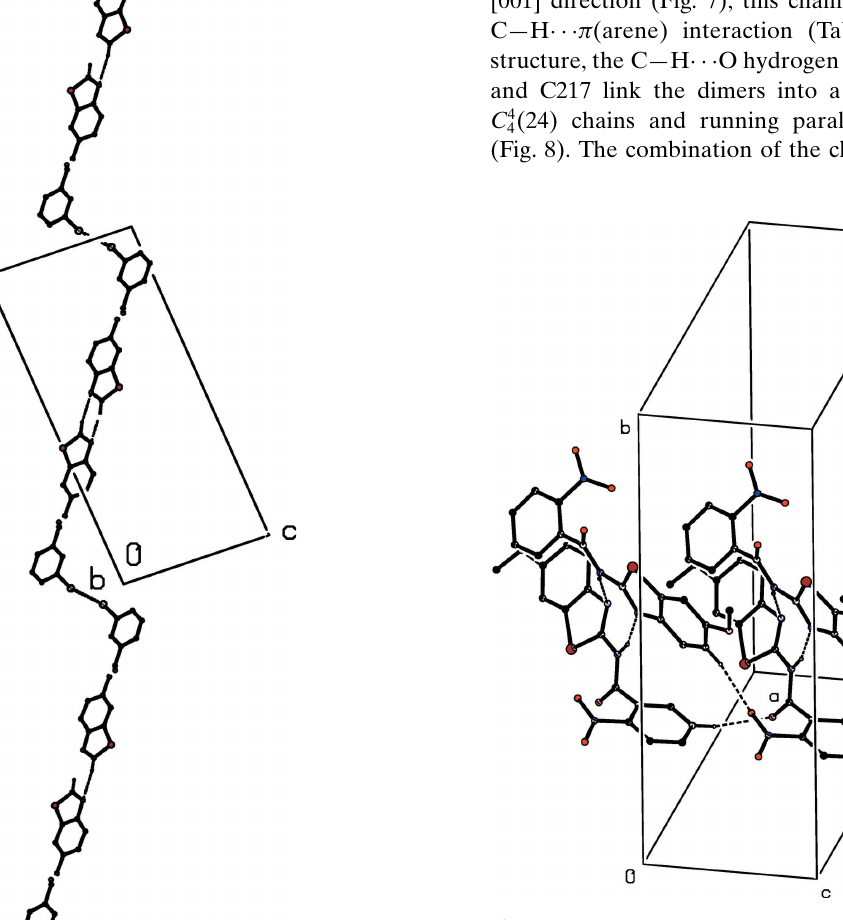
Figure 7 Part of the crystal structure of (II) showing the formation of a chain of R 2 (8) and R 3 (18) rings running parallel to [001] and built from N—H (cid:3)(cid:3)(cid:3) N 2 3 and C—H (cid:3)(cid:3)(cid:3) O hydrogen bonds. Hydrogen bonds are drawn as dashed lines and, for the sake of clarity, the H atoms not involved in the motifs shown have been omitted.